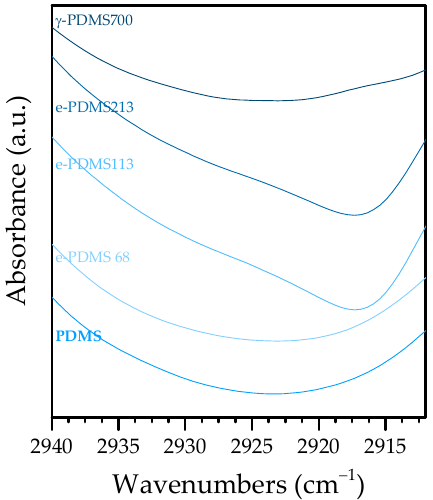
Figure 4. PDMS:FTIR spectra of PDMS as received, after e-beam irradiation with accumulated doses of 68, 113 and 213 kGy, and after γ-irradiation with accumulated dose of 700 kGy. However, a possibly relevant difference is the presence of a very discrete shoulder at 2927–2917 cm − 1 in the spectra of e-PDMS113 and e-PDMS213 Figure 5). This wavenumber is associated with an asymmetric stretching of C—H in methylene which is the result of scission of Si—C and C—H bonds and subsequent recombination to longer aliphatic chains where —CH 2 — is present, that is C n ≥ 2 H n+1 , if it remains bound to the polymeric chain or C n ≥ 2 H n+2 if it forms a free alkane. This would mean that recombined aliphatic fragments would integrate the new material’s matrix or, at the very least, that free alkanes would remain trapped in it [10].